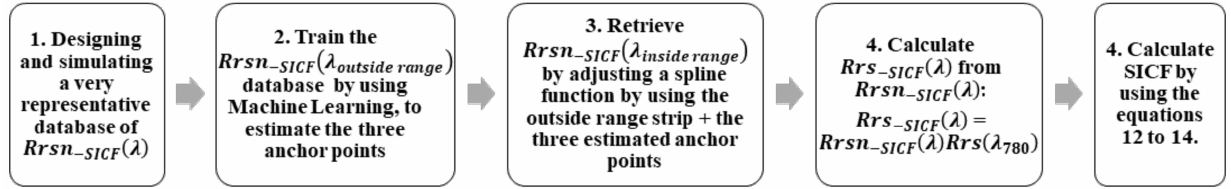
Figure 5. Scheme summarizing the methodology followed in the development of the SICF retrieval algorithm.